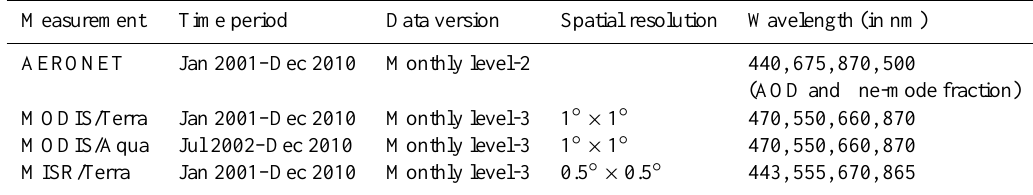
Table 2. Datasets used in this